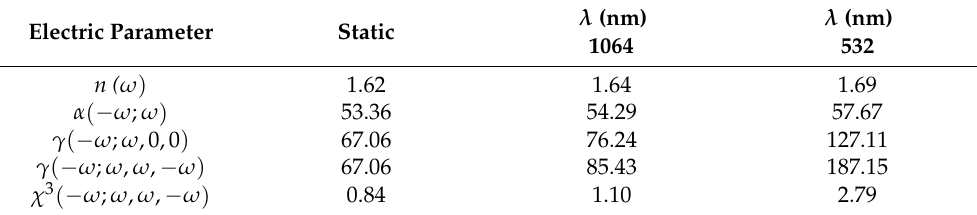
(cid:16) (cid:1) 2 (cid:17) × 10 − 20 (cid:0) m for several organic crystals at V